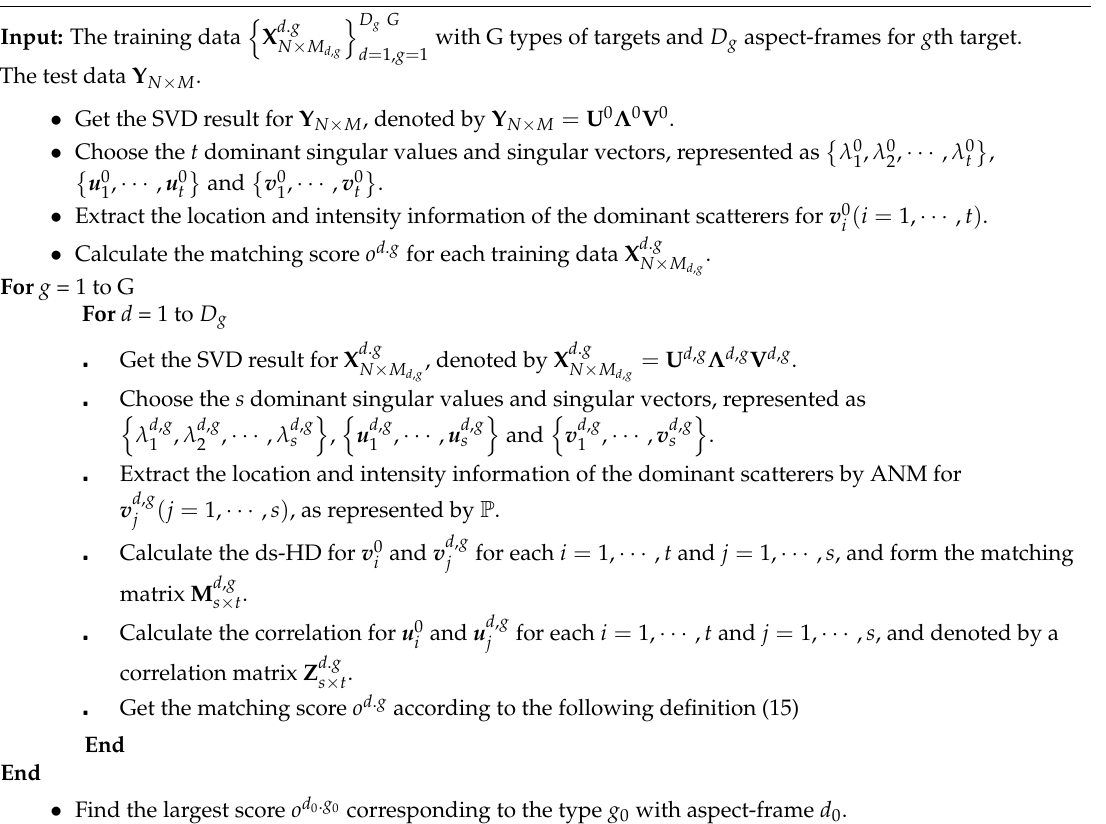
Table 1. Algorithmic recap of the SSM-ANM method. Algorithmic Recap of the SSM-ANM